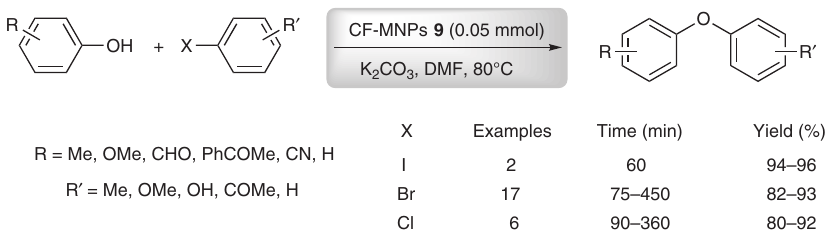
Scheme 8: CF-MNPs 9 catalyzed C-O coupling reaction of various aryl halides and